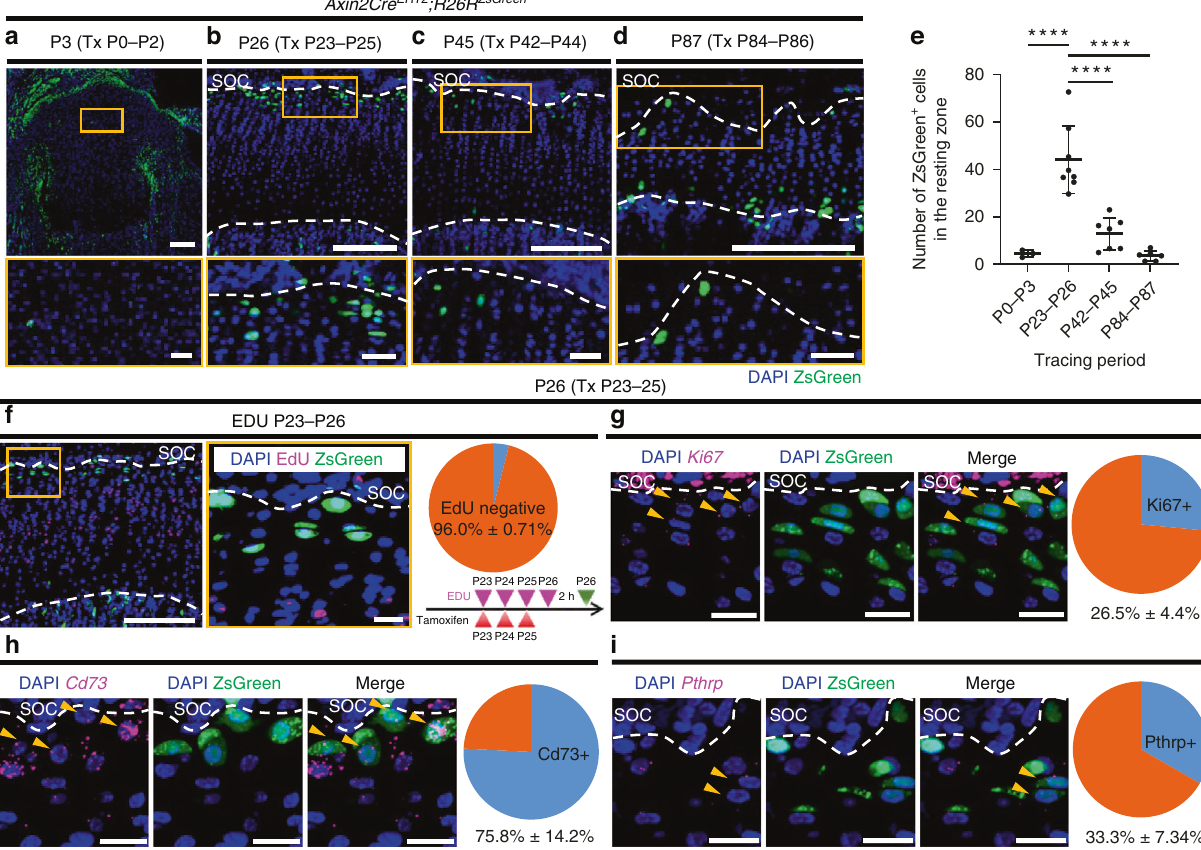
Fig. 1 Identi fi cation and characterization of Axin2 + cells in the resting zone after secondary ossi fi cation center formation. a – d Axin2 + cells in the proximal tibial growth plate in Axin2Cre ERT2 ;R26R ZsGreen mice. Axin2 + cells were labeled one day after three consecutive daily injections of tamoxifen (120 μ g·g − 1 body weight) from P0 ( n = 3) ( a ), P23 ( n = 8) ( b ), P42 ( n = 7) ( c ), and P84 ( n = 6) ( d ). Bottom panels show magni fi ed views of the resting zone of the growth plate. e Quanti fi cation of ZsGreen + cells in the resting zone across different time points reported above in ( a – d ). Adjusted **** P = < 0.000 1. f – i Characterization of Axin2 + cells in the resting zone of the proximal tibial growth plate in Axin2Cre ERT2 ;R26R ZsGreen mice one day after three consecutive daily tamoxifen injections from P23. f Representative images of EdU labeling and Axin2 + cells and the percentage of EdU-negative cells among Axin2 + cells ( n = 3). EdU (30 μ g/g body weight) was injected daily from P23 to P26, and mice were euthanized 2 h after the last administration of EdU. g Representative images of in situ hybridization of Ki67 and Axin2 + cells and the percentage of Ki67 + cells among Axin2 + cells ( n = 3). Arrow heads, Axin2 + cells expressing Ki67 . h Representative images of in situ hybridization of Cd73 and Axin2 + cells and the percentage of Cd73 + cells among Axin2 + cells ( n = 3). Arrow heads, Axin2 + cells expressing Cd73 . i Representative images of in situ hybridization of Pthrp and Axin2 + cells and the percentage of Pthrp + cells among Axin2 + cells ( n = 3). Arrow heads, Axin2 + cells expressing Pthrp . Tx tamoxifen, SOC secondary ossi fi cation center. The white dashed lines demarcate the growth plate from the surrounding tissues. Scale bars: 200 μ m ( a – d [upper panels], f [left]), 40 μ m ( a – d [bottom panels]), 20 μ m ( f [right], g – i ). All data are presented as the mean ± SD. Statistical signi fi cance was determined by one-way analysis of variance and Tukey ’ s RESULTS Identi fi cation of Axin2 + cells in the resting zone of the growth plate after SOC formation We fi rst investigated whether Axin2-expressing cells contain chondroprogenitors in the resting zone of the growth plate because the Axin2 gene has been successfully used to identify tissue-speci fi c stem cells in other tissues. 13 – 16 Administration of tamoxifen for three consecutive days induced Cre-mediated expression of the R26RZsGreen reporter, showing that Axin2 + (Fig. S2b), and 41.8% of the total Axin2 + cells were fractionated cells were rarely present in the resting zone of the neonatal growth CD45 - TER119 - Tie2 - AlphaV + Thy - 6C3 - CD105 - CD200 + cells (Fig. S2c). plate (Fig. 1a and e). However, these cells appeared in the resting zone after SOC formation (Fig. 1b, proximal tibia and Fig. S1, distal To test whether Axin2 + cells and their descendants have stem femur), which is consistent with a previous study, 17 and the cell-like properties in cultured conditions, we isolated the cells from the growth plate of Axin2Cre ERT2 ;R26R ZsGreen mice at P37 after number of these Axin2 + cells in the resting zone decreased when tamoxifen injections at P23-P25 and expanded them by serial passaging. At Passage 6, the cells stopped proliferating; the population doubling level when they ceased proliferation was approximately 13.0. The percentage of ZsGreen-positive cells was